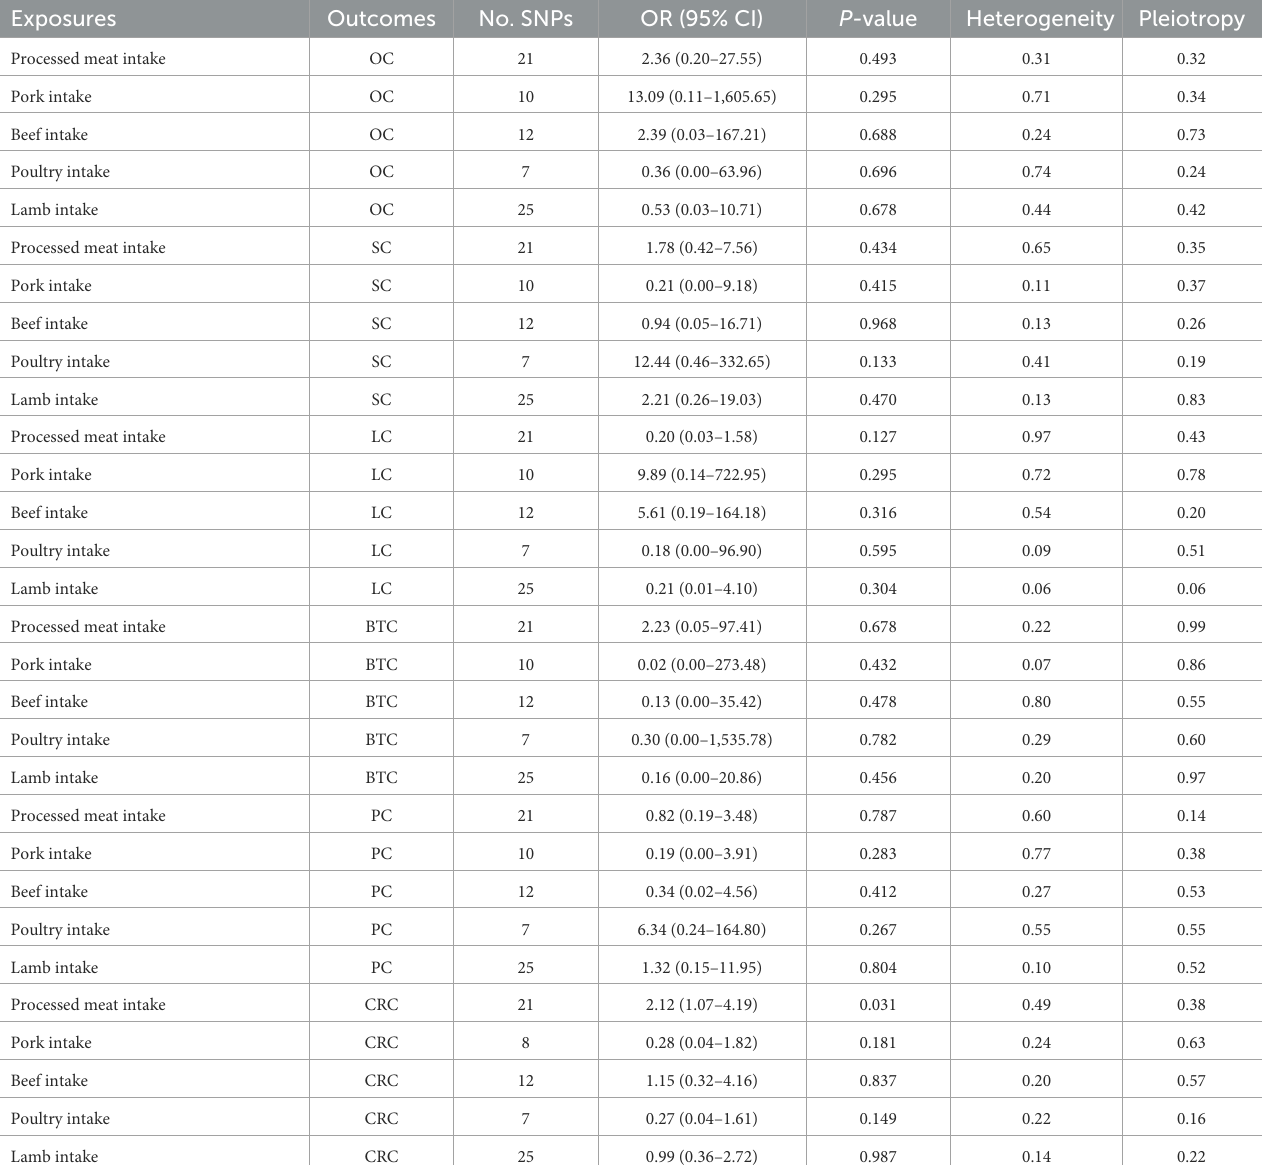
TABLE 2 IVW analysis results for five meat intakes and six digestive tract